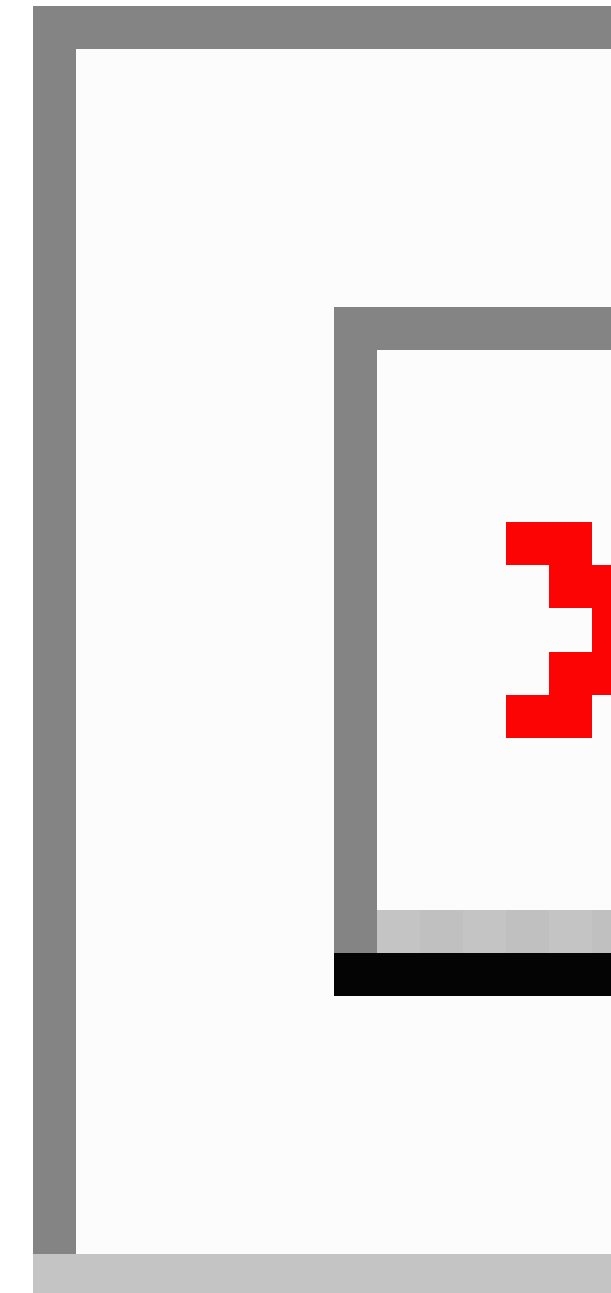
Figure 2. Flow of patients through the